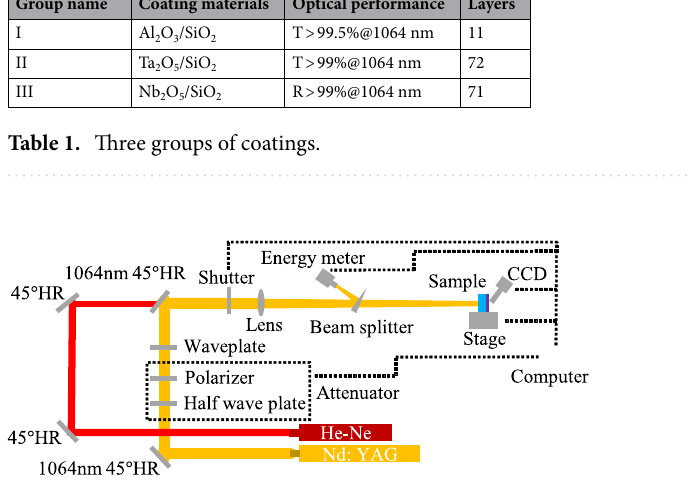
Figure 1. Laser damage test